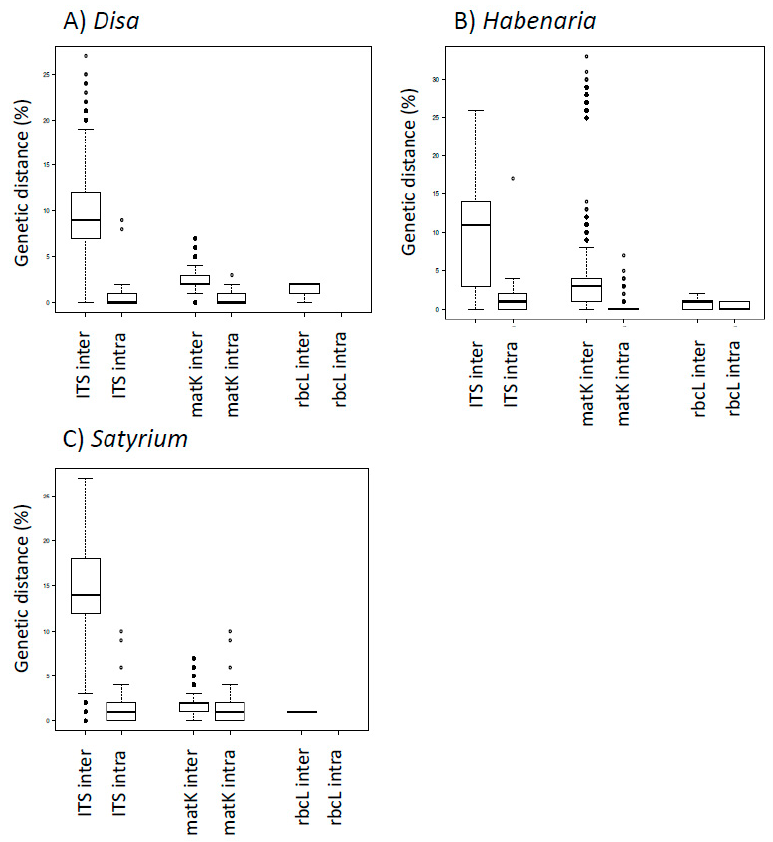
Figure 3. Boxplots showing the inter- and intraspecific variation for Disa ( a ) , Habenaria ( b ) and Satyrium ( c ) based on genetic diversity . In total, 15 orchid species were identified using DNA barcoding: Brachycorythis sp. SJK7, Disa